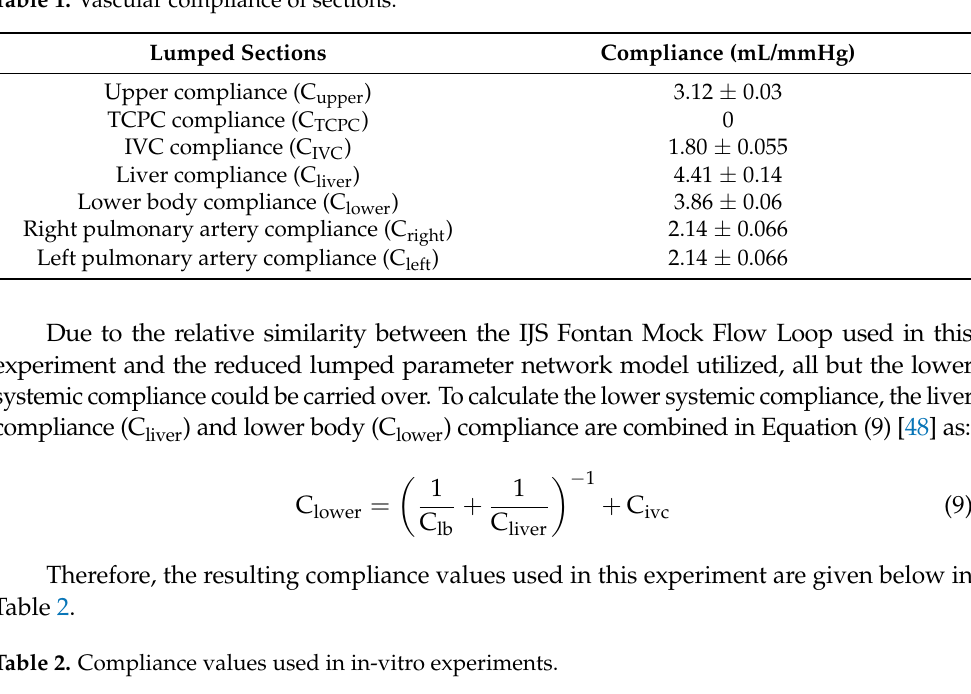
Table 1. Vascular compliance of sections.